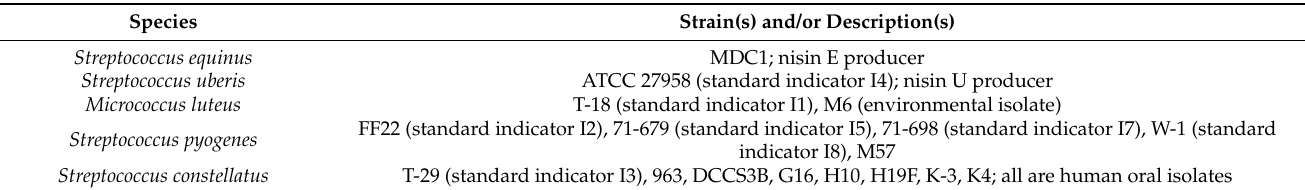
Table 1. Bacterial strains used in this